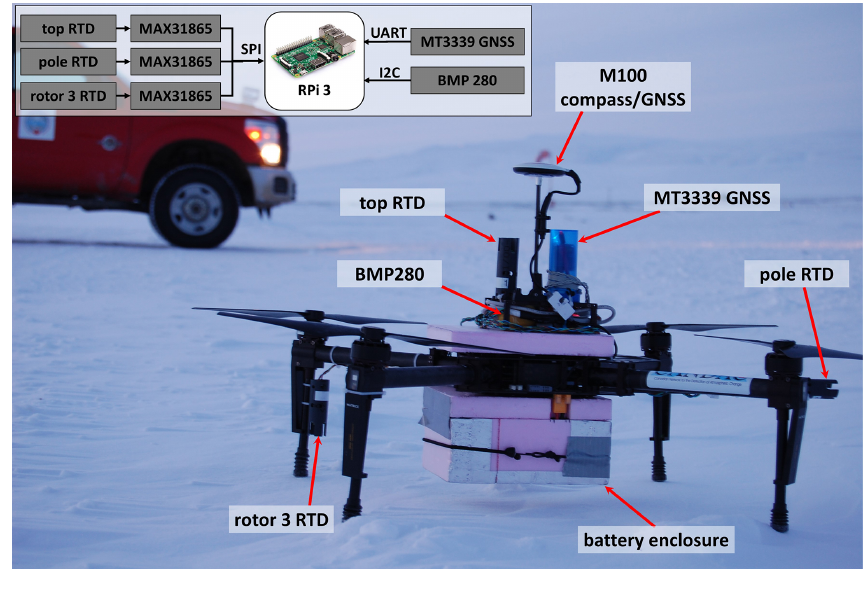
Figure 1. The DJI M100 drone and its payload.